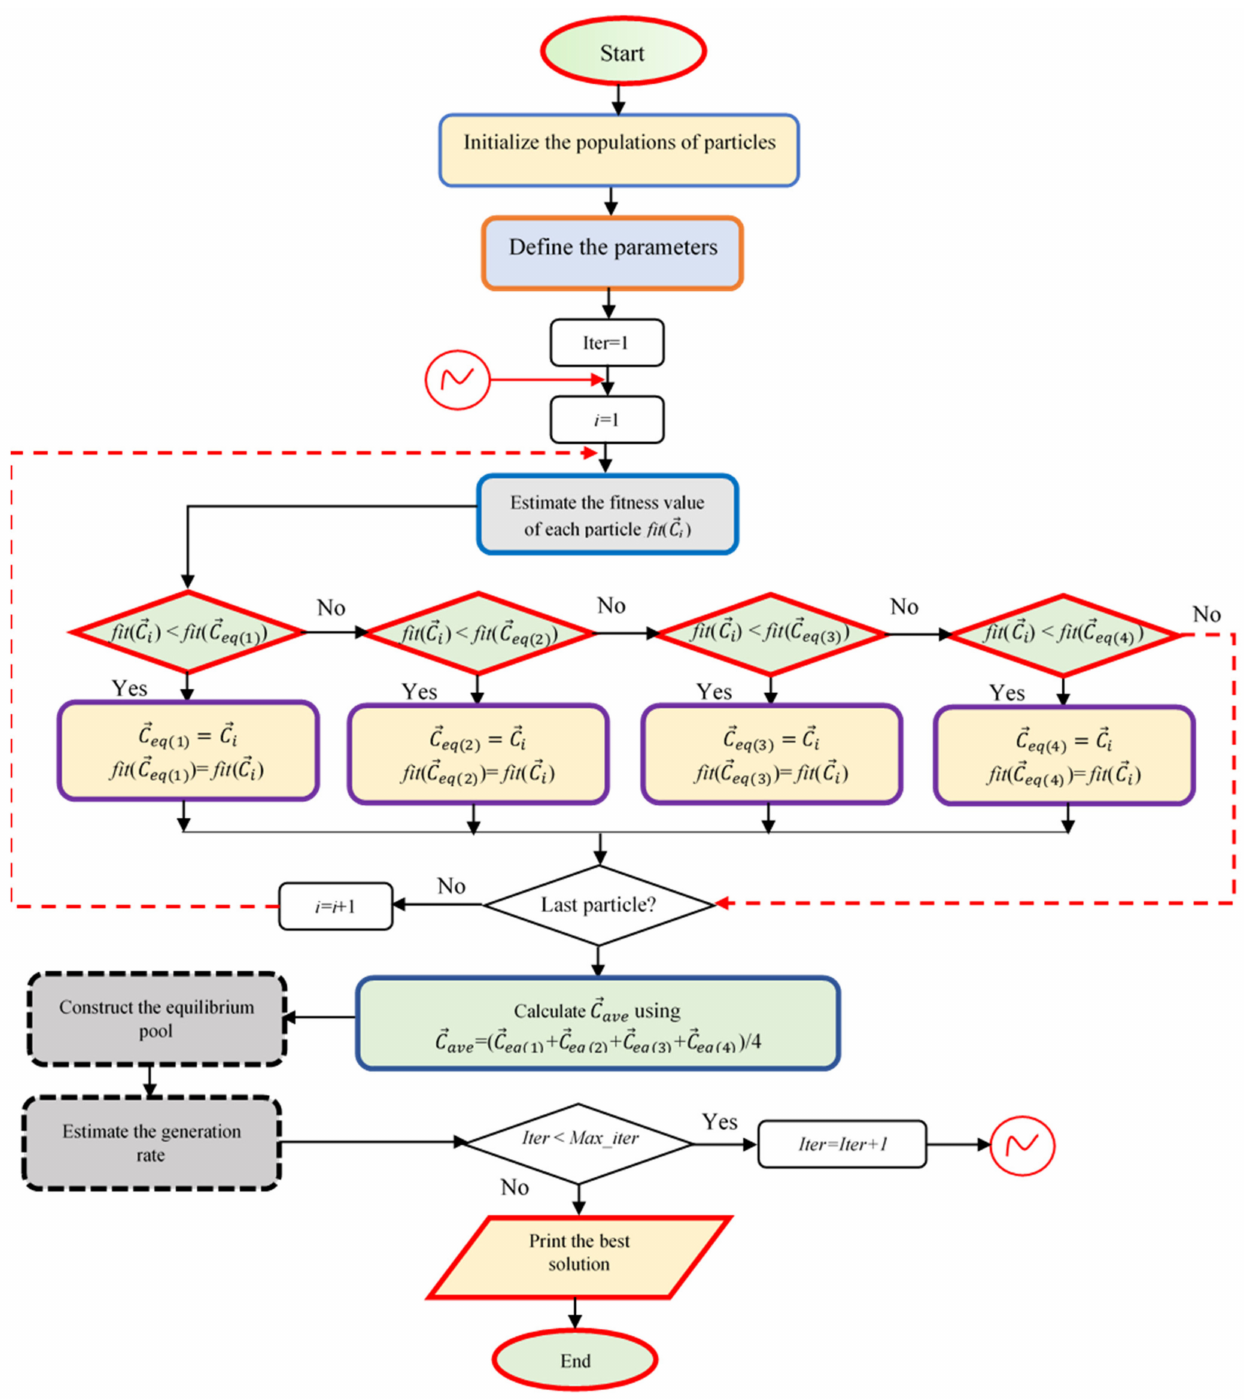
Figure 1. Optimization process of